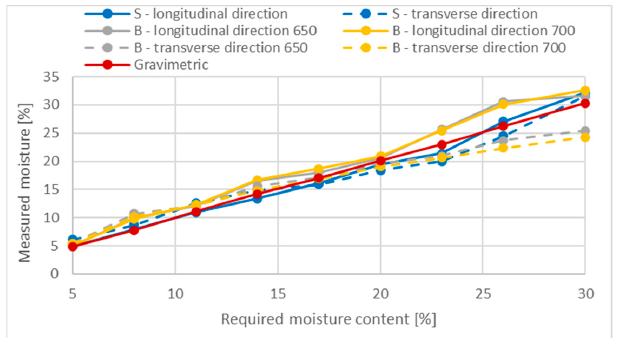
Figure 8. Dependence of the average measured values of MC using the GMK 100 moisture meter on the MC of different types of wood (S—spruce, B—beech) and in different directions in the MC range of 5% to 30%.